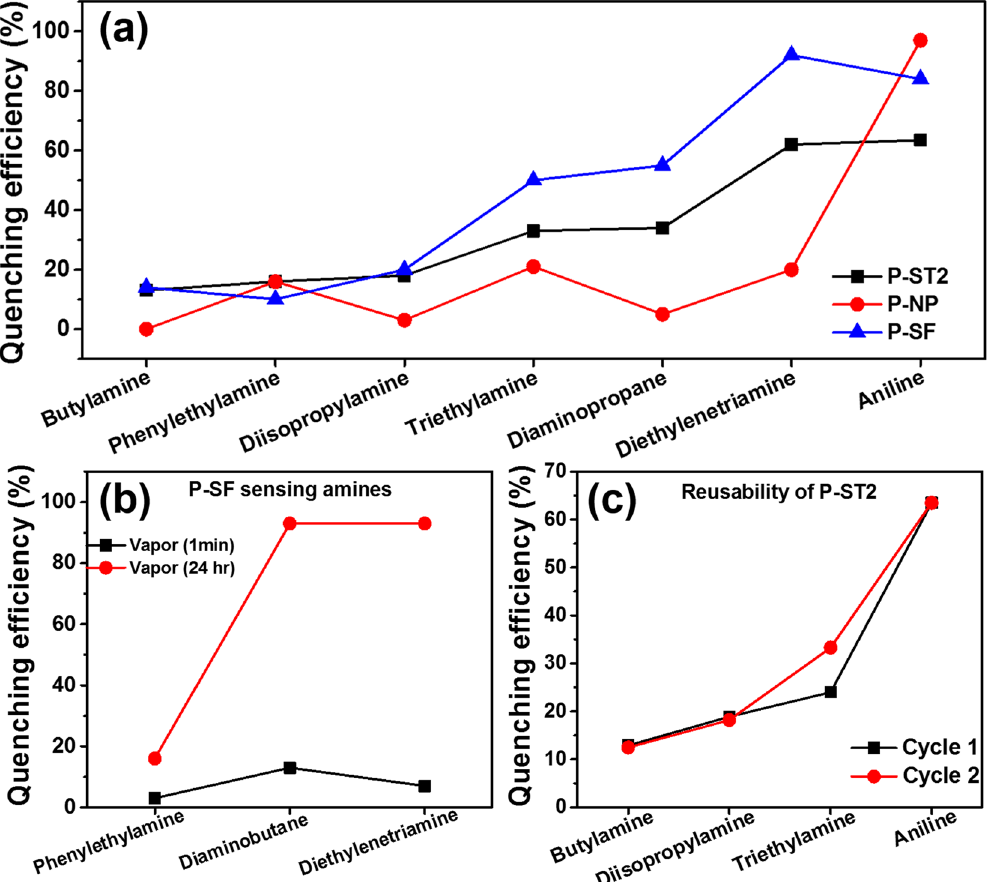
Figure 6. Percentage quenching efficiency of P-ST2 , P-SF and P-NP nanoparticles in sensing ( a ) butylamine, diisopropylamine, triethylamine, aniline and biogenic amines such as phenylethylamine, diaminopropane and diethylenetriamine in solution. ( b ) P-SF nanoparticles sensing biogenic amines both in solution (~1 mins) and vapor phase (24 hr). ( c ) Reusability of P-ST2 particles for sensing amines in THF solution. Excitation wavelength was 350